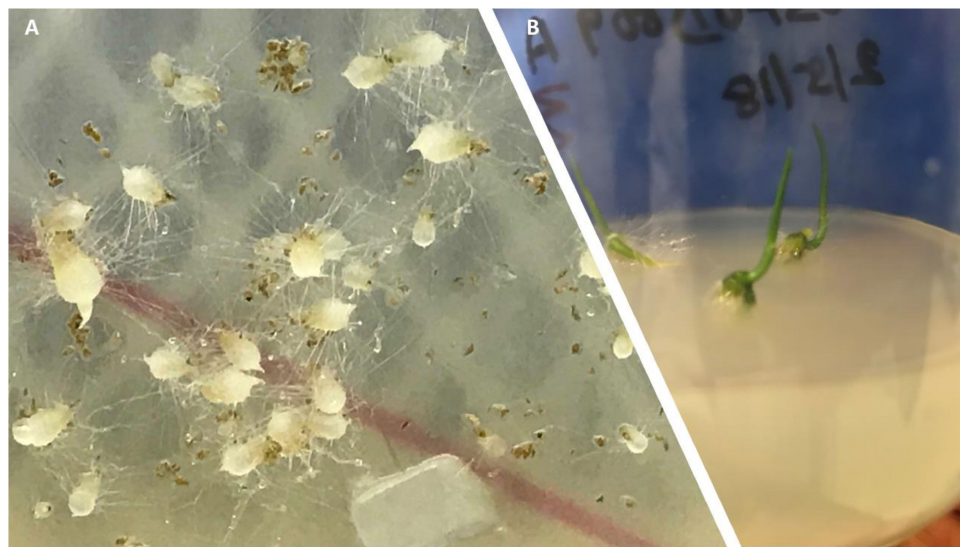
Figure 5. Symbiotic seed germination of D. incarnata subsp. ochroleuca with Tul1 isolate 03DP009 (closest match JX649077): ( A ) protocorms and developing seedlings ( B )